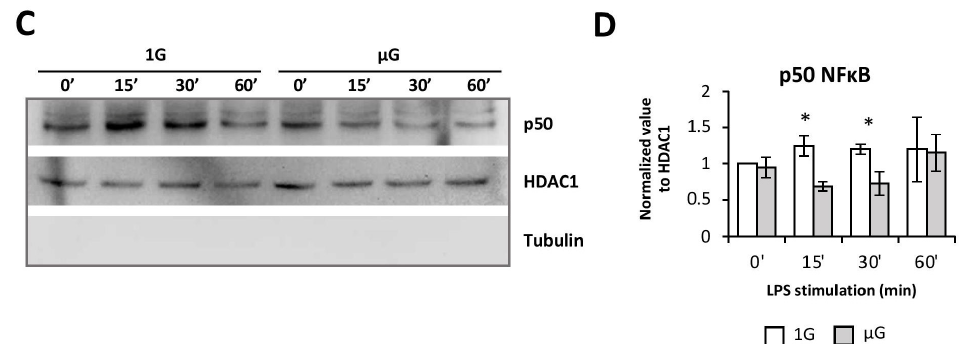
Figure 4. Simulated microgravity reduces NF κ B signaling following BMDC activation. Mouse BMDCs were differentiated for 7 days with Flt3-L followed by 24 h in the absence (1G) or presence ( µ G) of simulated microgravity. Cells were then stimulated with LPS (100ng/mL) for the indicated times. ( A , B ) Total and phosphorylated MAPK family members in BMDCs detected by Western blot of whole-cell lysate. A representative blot out of three independent experiments with similar results is shown ( A ). Graphs represent the mean ± SEM of normalized phosphorylated/total amount ratio of respective proteins ( B ). ( C , D ) Nuclear extracts were used to determine the amount of translocated p50 using Western blot. A representative blot out of four independent experiments with similar results is shown ( C ). Graph represents the mean ± SEM of p50 normalized nuclear amounts in BMDC. Tubulin was used to verify the absence of cytoplasm proteins in nuclear extracts. t -test or Mann–Whitney test was used to reveal statistically significant differences. * p <